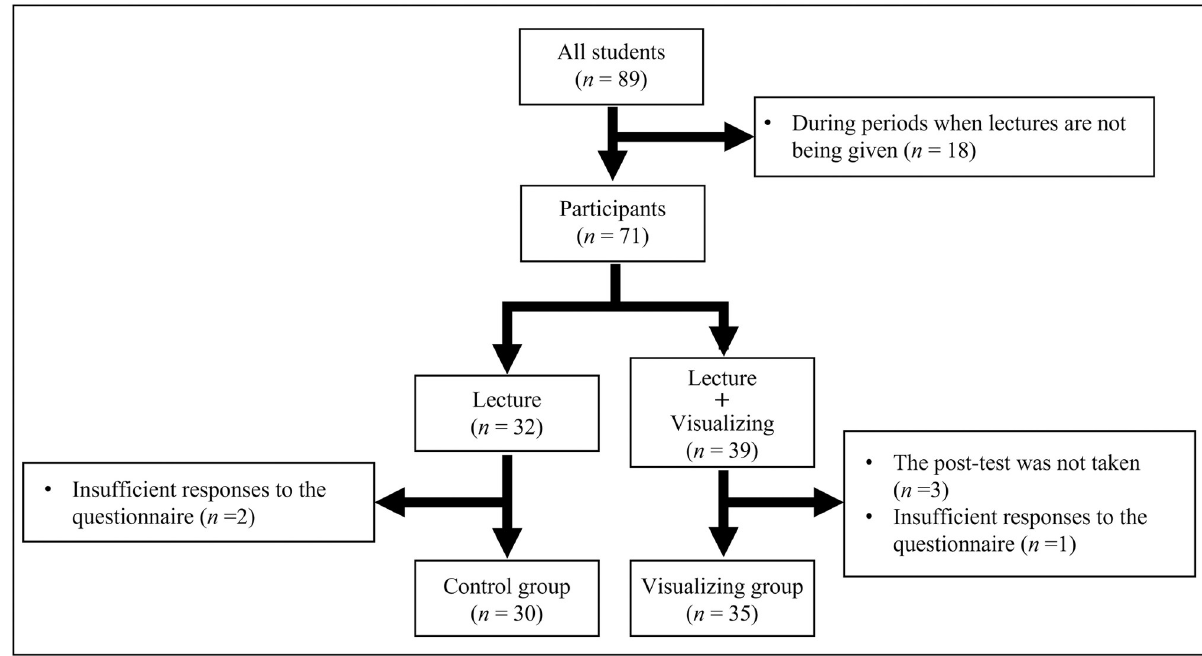
Fig 1. Flow chart of the participants’ selections and